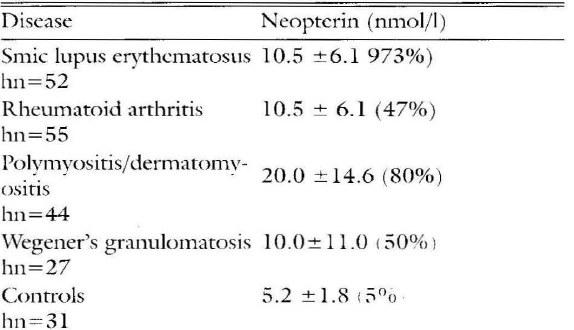
Table 2. Scrum concentrations of neopterin in patients with autoimmune rheumatic diseases and in normal controls (mean±S.D., percent with levels above the 95 th percentile of healthy controls) Disease